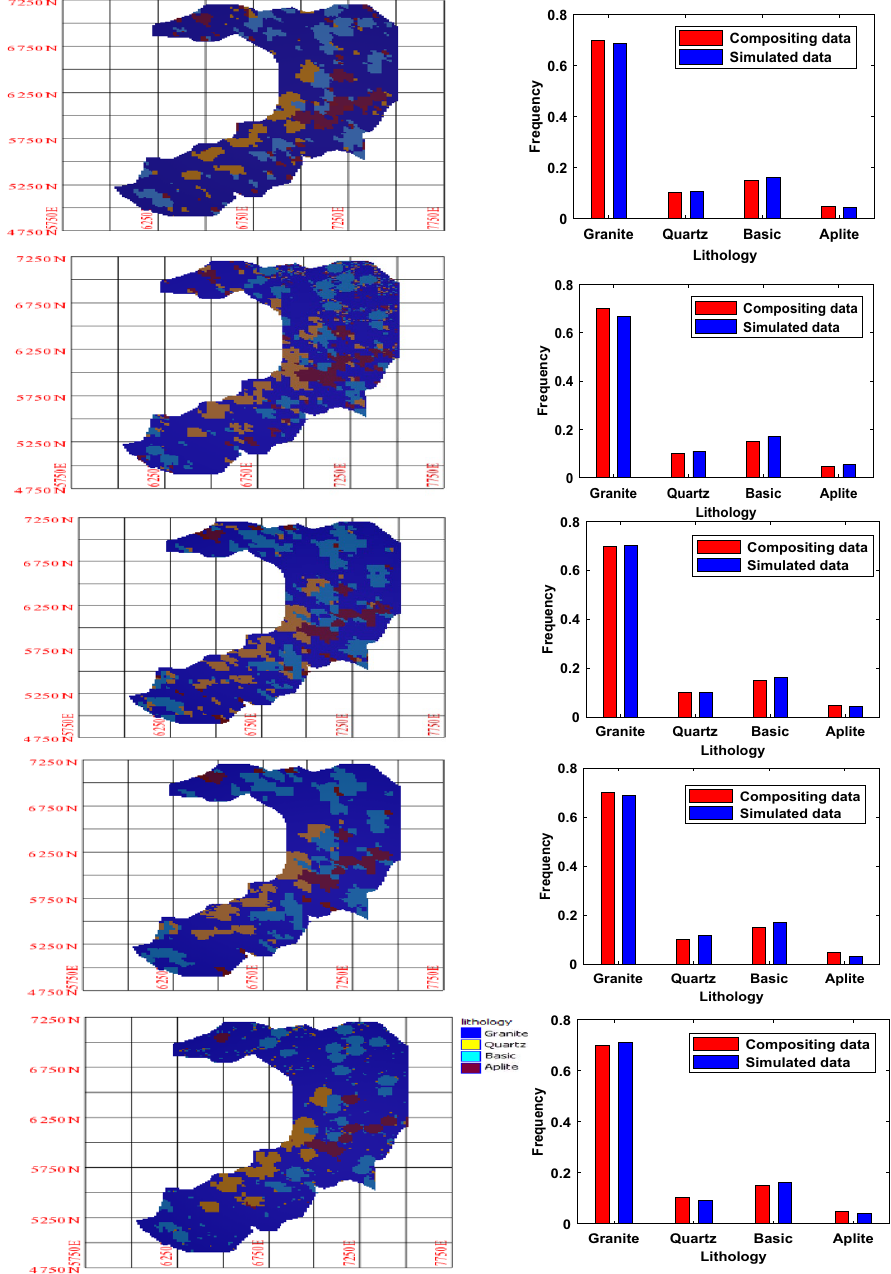
Figure 9. Five simulated maps and bar charts among 50 simulated realizations of v-transformed copula-based model for bench 448 m